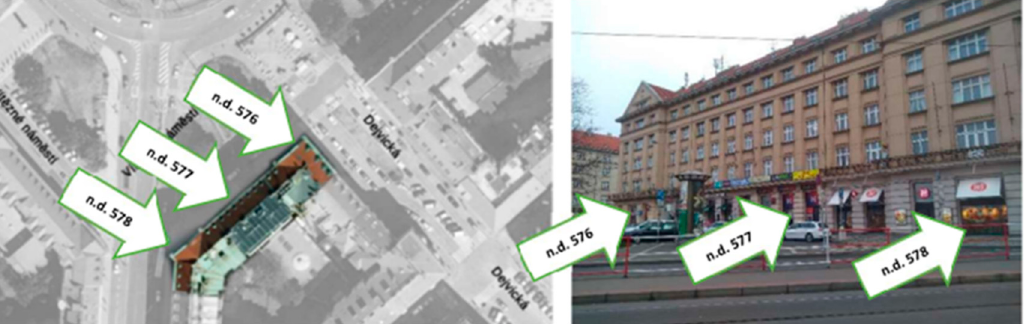
Figure 3. Designation of buildings (their descriptive numbers), where the energy performance of buildings was solved in the experiment, Prague 6-Bubene č .